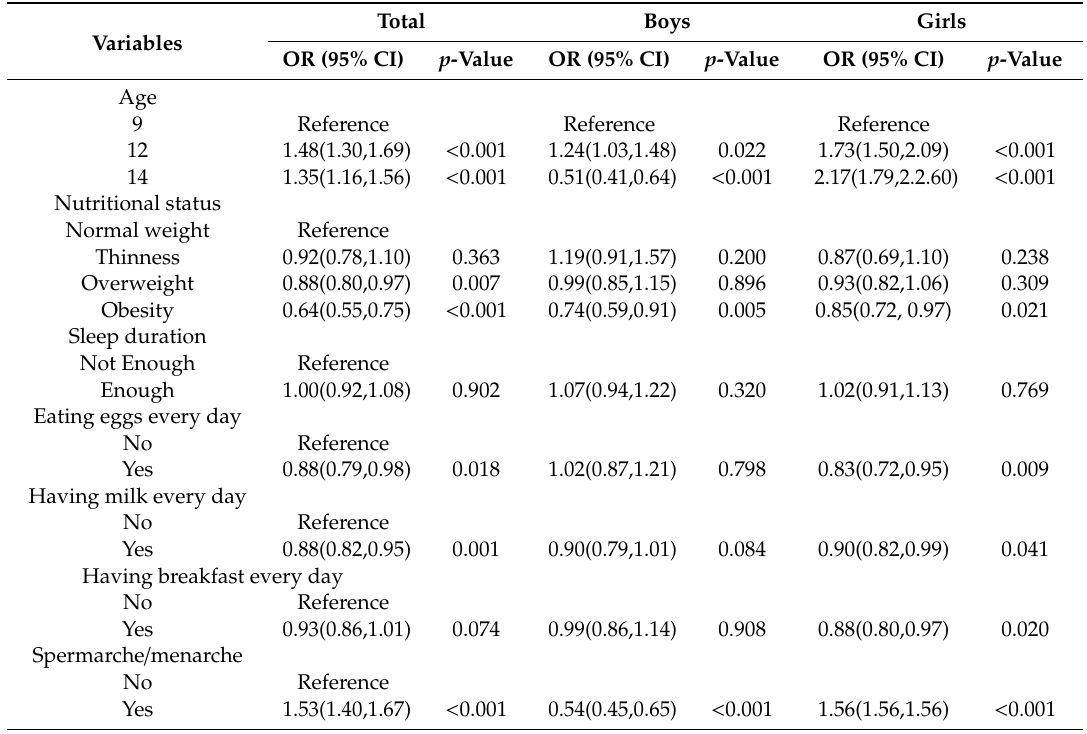
Table 4. Association between anemia and its risk factors in univariate models.